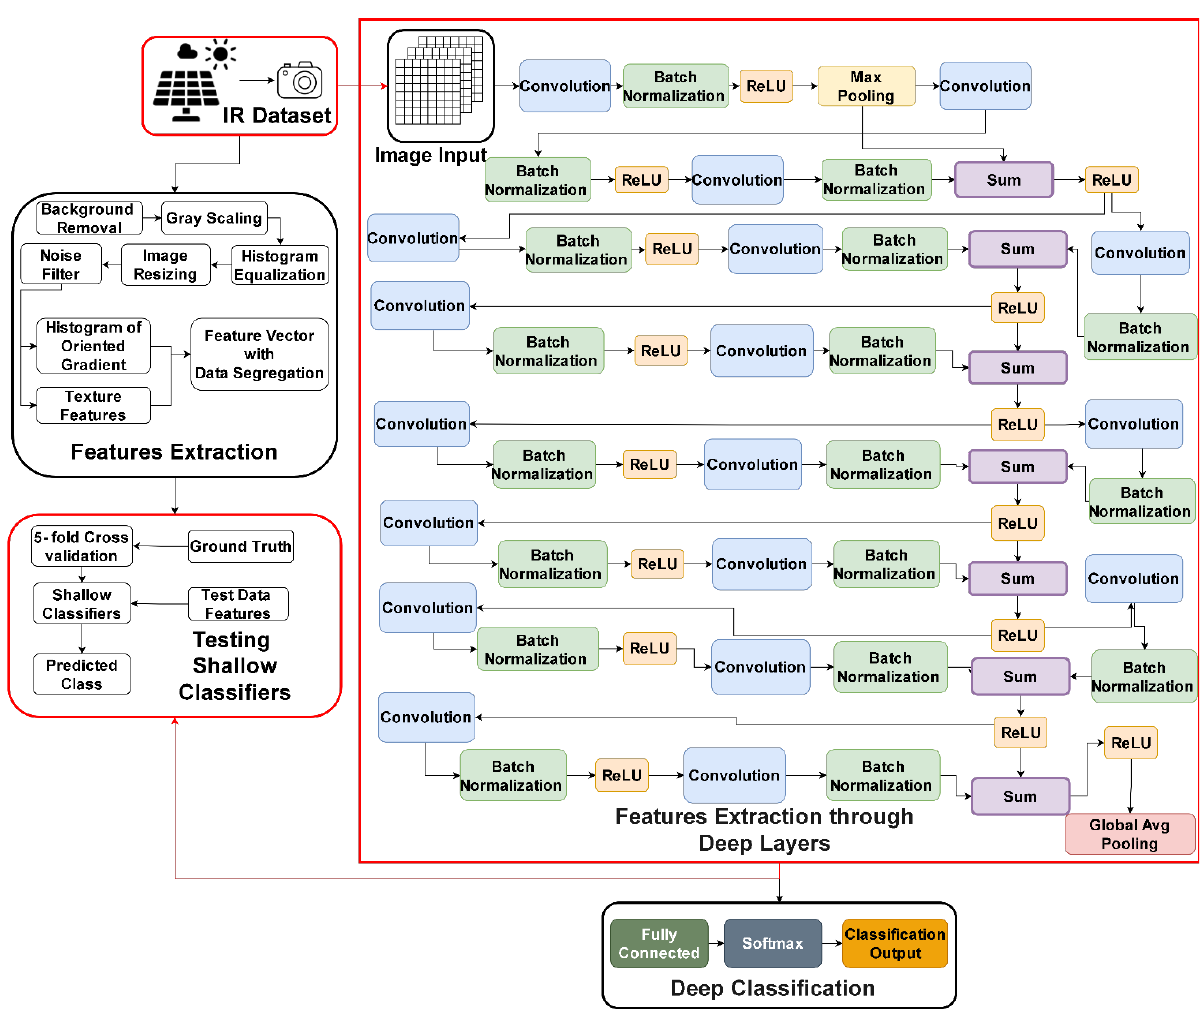
Figure 5. Proposed